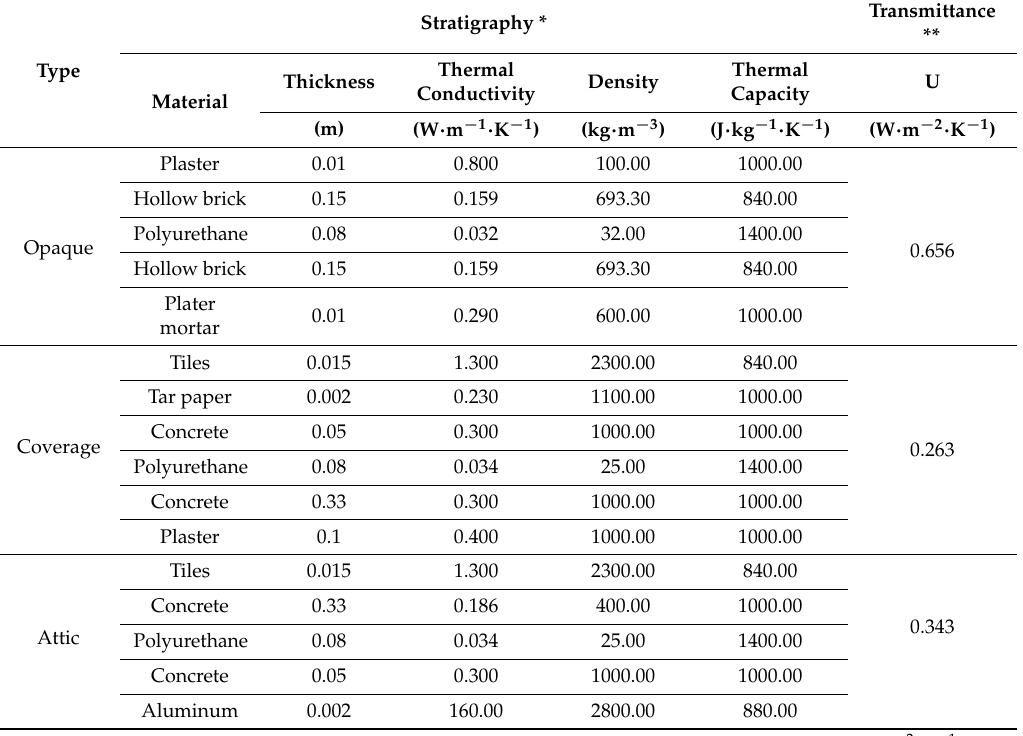
Table 2. Stratigraphy of the boundary surfaces of the air-conditioned rooms of the